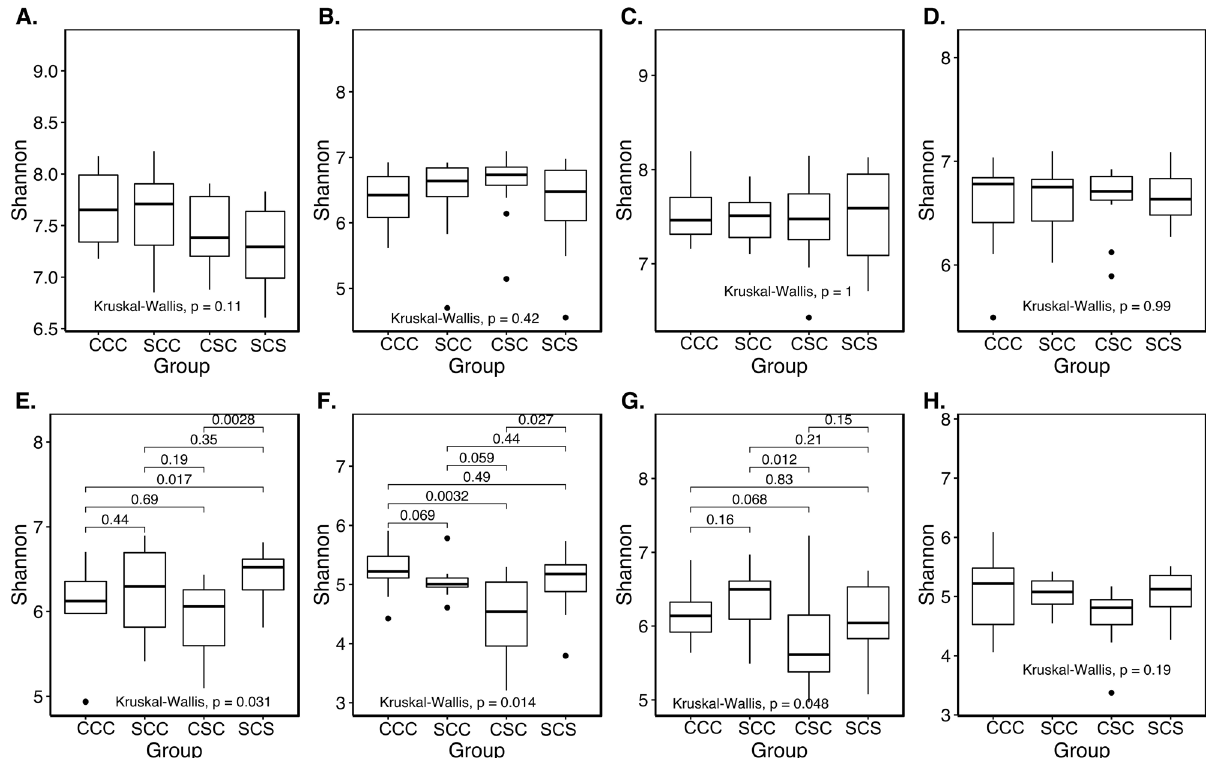
Figure 3. Alpha diversity estimated by the Shannon index. Bacterial ( A ) and fungal ( B ) diversities at the Monmouth site, and bacterial ( C ) and fungal ( D ) diversities at the Urbana site associated with bulk soil; bacterial ( E ) and fungal ( F ) diversities at the Monmouth site, and bacterial ( G ) and fungal (H) diversities at the Urbana site associated with roots are